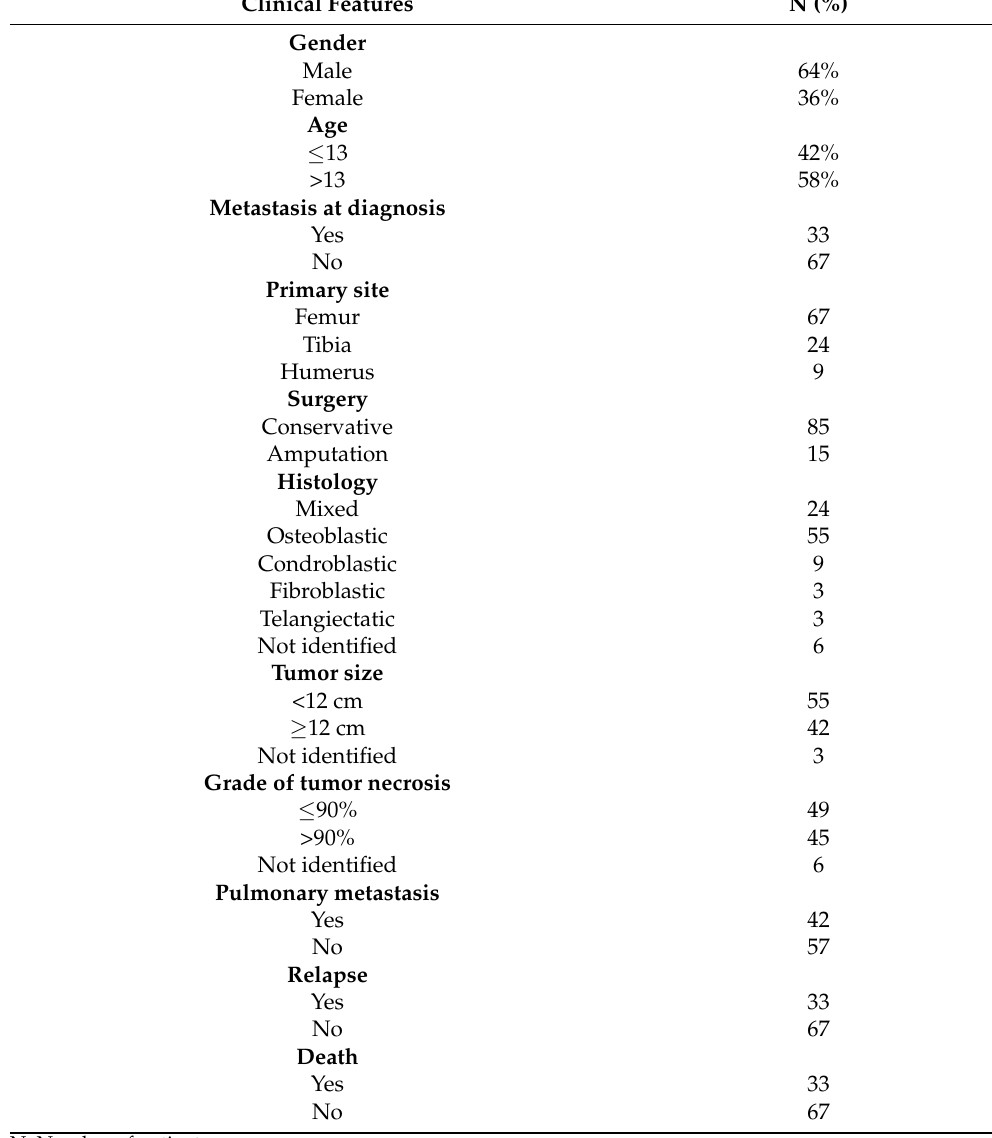
Table 2. Clinical features of OS